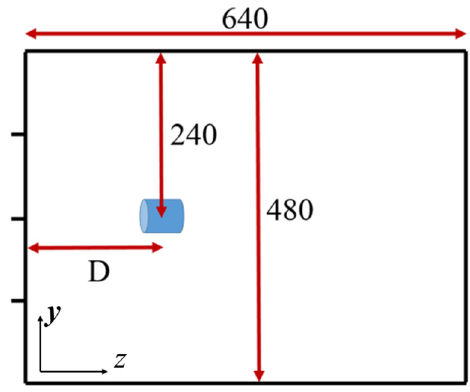
Figure 5. Explosive setting. Figure 5. Explosive